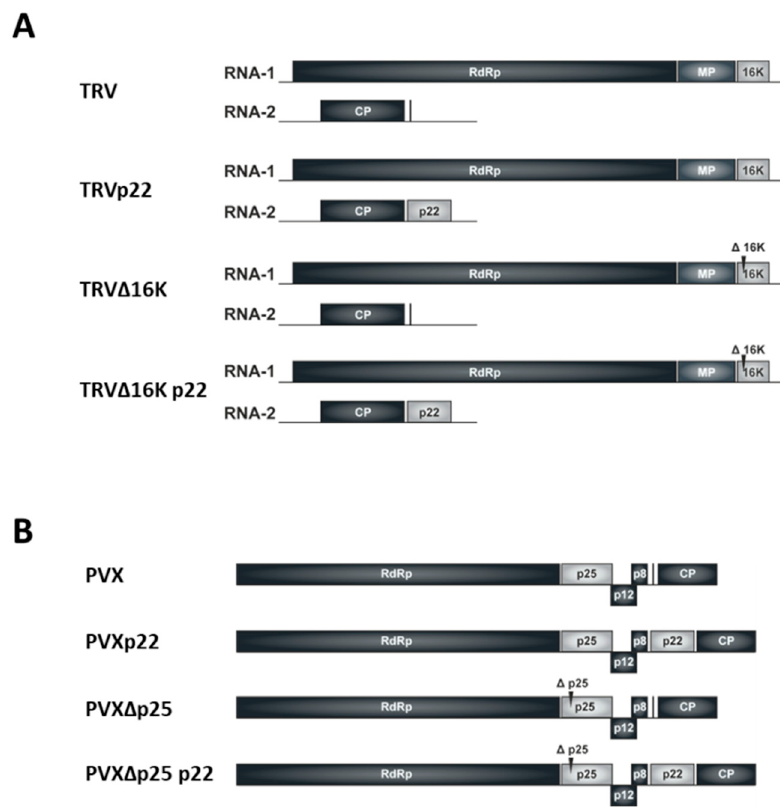
Figure 1. Schematic representation of Tobacco rattle virus (TRV) and Potato virus X (PVX) constructs used in this work. ( A ) TRV is the viral vector containing the infectious TRV cDNA. In TRVp22 the Tomato chlorosis virus (ToCV) p22 gene was inserted into a multiple cloning site (Mcs) on the viral RNA2 created after removing the two genes involved in nematode transmission of TRV. TRV ∆ 16K consists of an infectious TRV cDNA that harbors a premature stop codon in the RNA1-encoded 16K open reading frame (ORF) (arrowhead). In TRV ∆ 16Kp22, the ToCV p22 gene was inserted into the Mcs and a premature stop codon was created in the RNA1 encoded 16K ORF (arrowhead); ( B ) PVX is the viral vector containing the infectious PVX cDNA. PVXp22 consists of an infectious PVX cDNA clone that expresses ToCV p22 from a duplicated PVX CP promoter. PVX ∆ P25 consists of an infectious PVX cDNA clone harboring two stop codons in the P25 ORF (arrowhead). PVX ∆ P25p22 consists of an infectious PVX cDNA clone that expresses ToCV p22 and harbors two stop codons in the P25 ORF (arrowhead). A vertical black line shows the multiple cloning site.